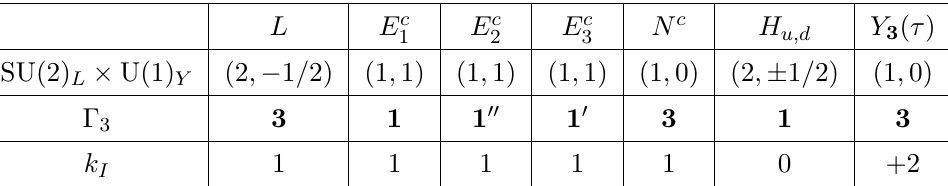
Table 3 . Representations and modular weights of matter super(cid:12)elds in the benchmark model of ref. [35]. Also shown are the level-3 weight-2 modular forms Y 3 ( (cid:28)